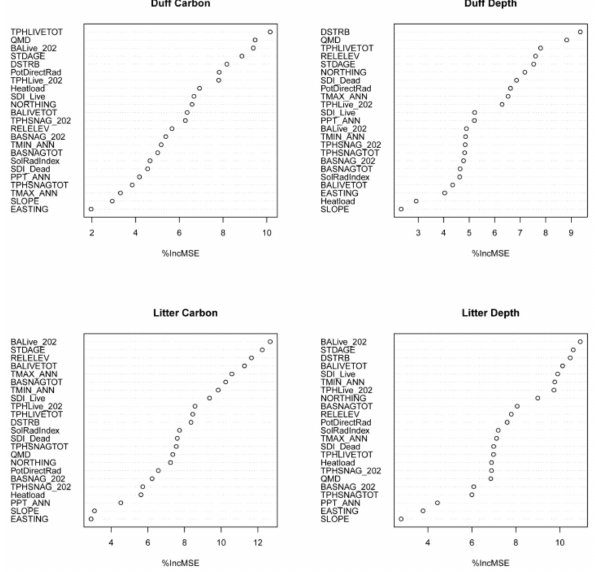
Figure 10. Variable of importance plot displaying ranked importance of predictor variables from random forests classifications used to predict each duff and litter response category for interior Douglas-fir stands throughout the Intermountain West, USA. Due to the continuous nature of the response variables, model ranking of the importance of predictor variables is delineated by the percent increase in mean square error (%MSE). Higher percent MSE values indicate variables that are more important to the classification. Both duff and litter carbon were based on loading estimates. Variable codes are defined in Supplementary File